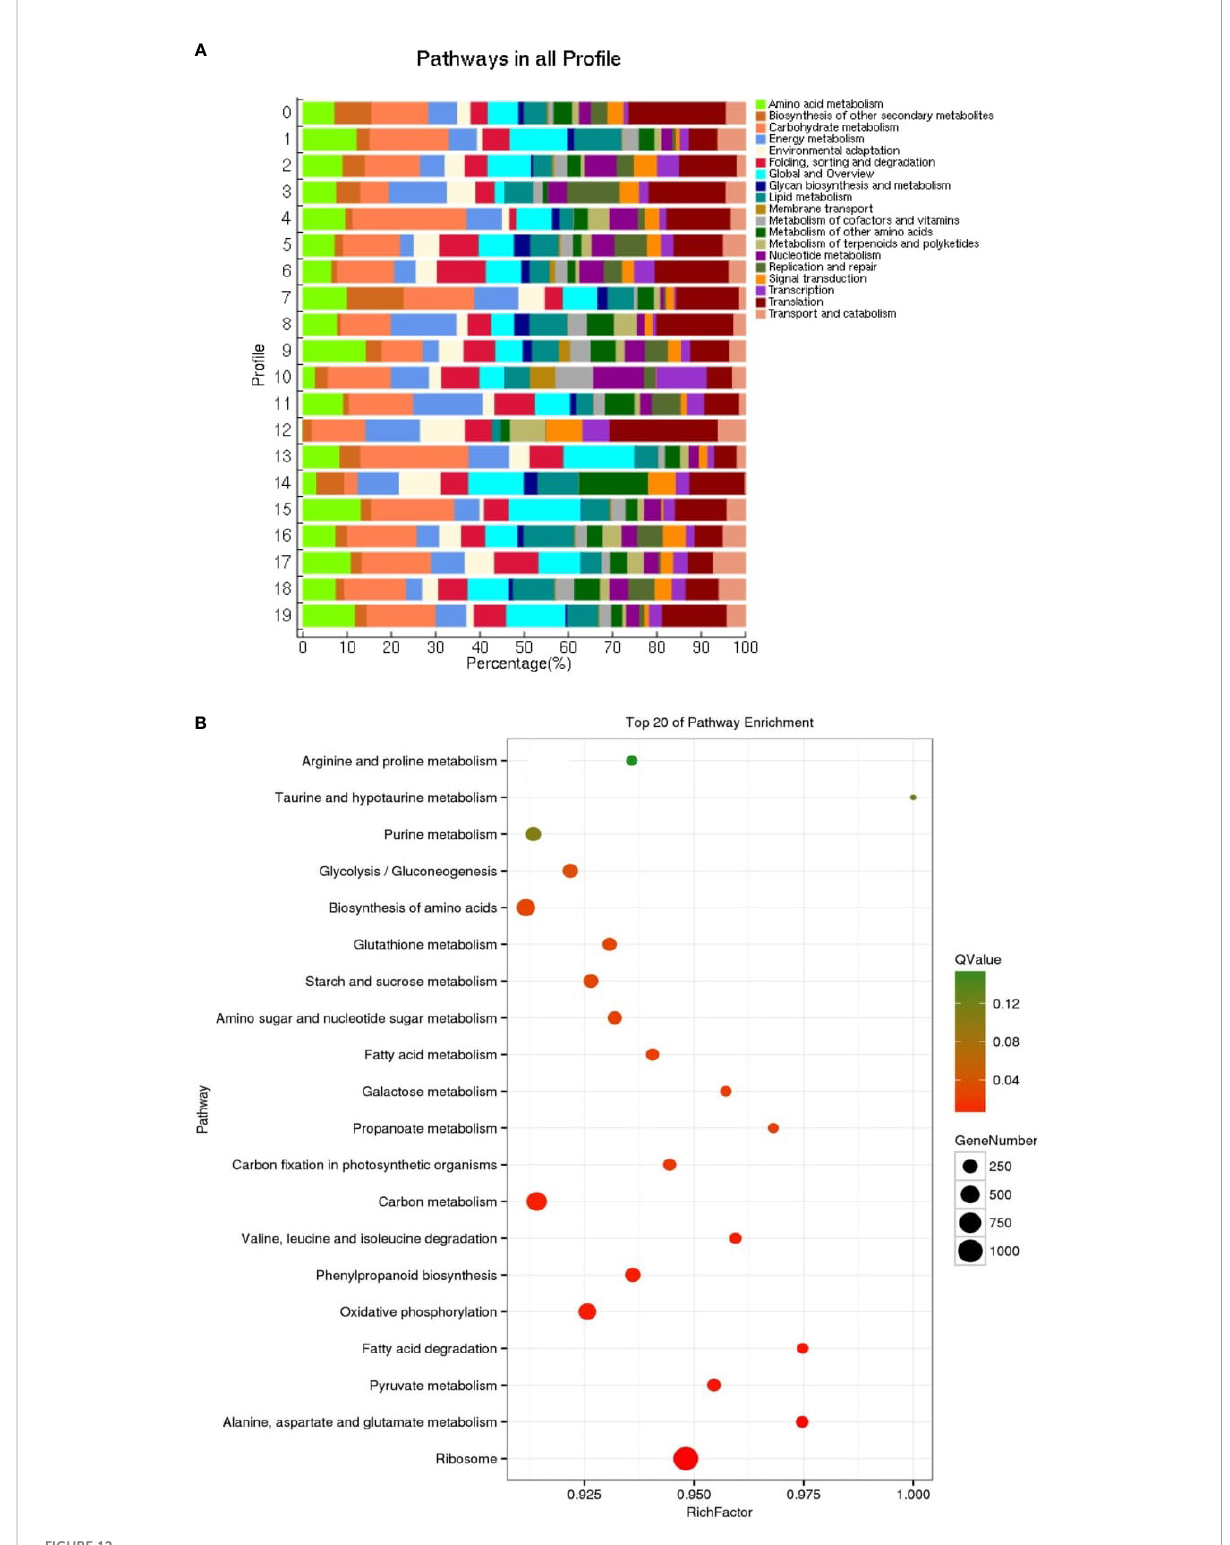
FIGURE 12 Distribution pathway (A) in all pro fi les and pathway enrichment (B) of all genes (top